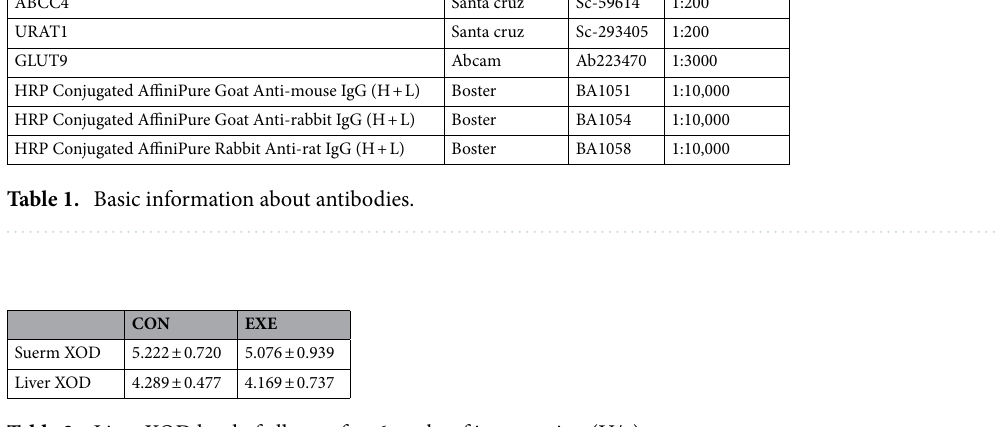
Table 2. Liver XOD level of all rats after 6 weeks of intervention